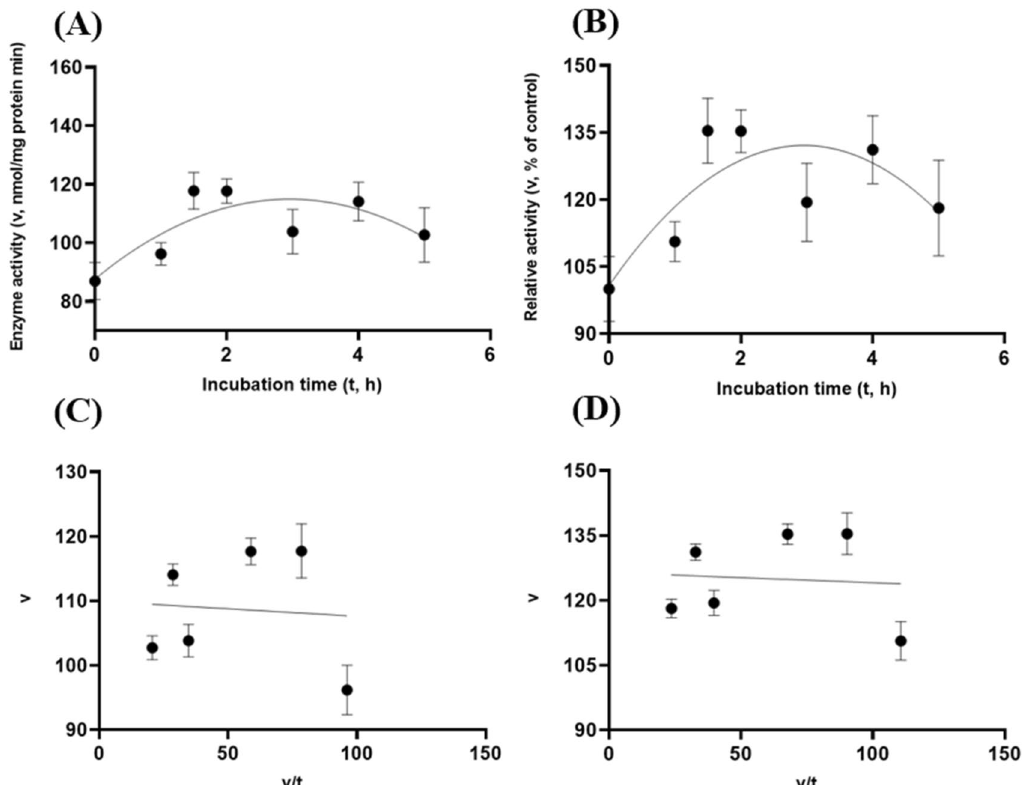
Figure 8. Experiment-2 of the gastric acidic pH effects (pH = 3.5) (with describing model parameter estimates ± SE ) on GH5-p4818Cel5_2A activity over a 5-h period after the gastric pH buffer being mixed with the crude GH5-p4818Cel5_2A enzyme preparation prior to further incubation for measuring cellulase activity with the carboxymethyl cellulose (CMC) substrate buffer in presence of dithiothreitol (DTT) (5 mM) and N 2 gas purging for 15 min at 37 °C. (A) Quadratic plot of the inhibition kinetic relationship between GH5- p4818Cel5_2A activity (v, mean ± SE, n = 12at each time point, nmol/mg protein•min) and incubation time (t, h) under the gastric pH 3.5 condition according to the quadratic response model established as: Y = 86.308 ( ± 6.209 ) + 19.458 ( ± 5.703 ) x − 3.278 ( ± 1.068 ) x 2 , P < 0.0001 for intercept; P = 0.001 for the linear parameter estimate; and P = 0.003 for the quadratic parameter estimate; R 2 = 0.29 , n = 84; and alternatively, according to the linear response model established as y = 99.305 ( ± 4.771 ) + 2.638 ( ± 1.658 ) x , P < 0.0001 for the intercept; and P = 0.116 for the slope; r 2 = 0.207 , n = 84; (B) Quadratic plot of the inhibition kinetic relationship between the relative GH5-p4818Cel5_2A activity (v, mean ± SE, n = 12at each time point, % of the control group measured at I C of 100.000 ± 7.523 at 0-min exposure to the gastric pH 3.5 incubation) and incubation time (t, h) under the gastric pH-3.5 condition according to the quadratic response model established as: Y = 99.245 ( ± 7.139 ) + 22.374 ( ± 6.558 ) x − 3.769 ( ± 1.228 ) x 2 , P < 0.0001 for intercept; P = 0.001 for the linear parameter estimate; and P = 0.003 for the quadratic parameter estimate; R 2 = 0.29 , n = 84; and alternatively, according to the linear response model established as y = 114.2 ( ± 5.486 ) , P < 0.0001 for the intercept; and P = 0.116 for the slope, r 2 = 0.207 , n = 84; (C ) the Eadie-Hofstee linear plot between the GH5-p4818Cel5_2A enzyme activity (v, mean ± SE, n = 12at each data point, nmol/mg protein•min) and the v/t ratio established as y = 98.265 ( ± 5.708 ) + 0.200 ( ± 0.096 ) x , P < 0.0001; for the intercept and P = 0.041 for the slope, r 2 = 0.059 , n = 72; and (D ) the Eadie-Hofstee linear plot between the relative GH5-p4818Cel5_2A enzyme activity (v, mean ± SE, n = 12at each data point, % of the control group measured at I C of 100.000 ± 7.523) at 0-min exposure to the gastric pH 3.5 incubation) and the v/t ratio established as y = 113.000 ( ± 6.563 ) + 0.200 ( ± 0.096 ) x , P < 0.0001 for the intercept; and P = 0.041 for the slope, r 2 = 0.05 , n =